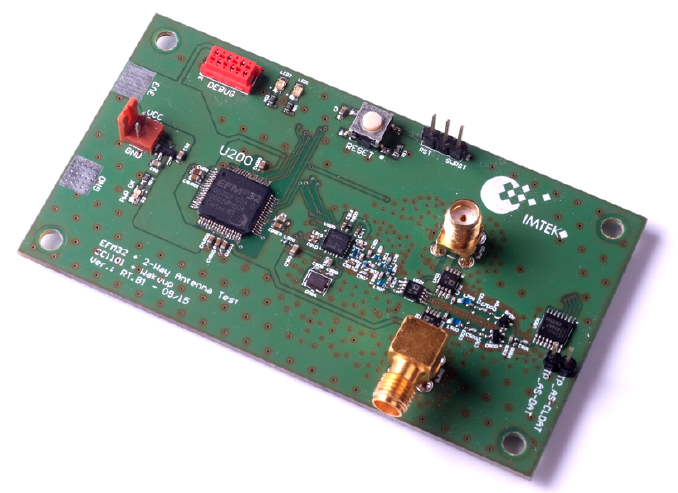
Figure 6. Photo of the wireless sensor node with equal gain diversity.